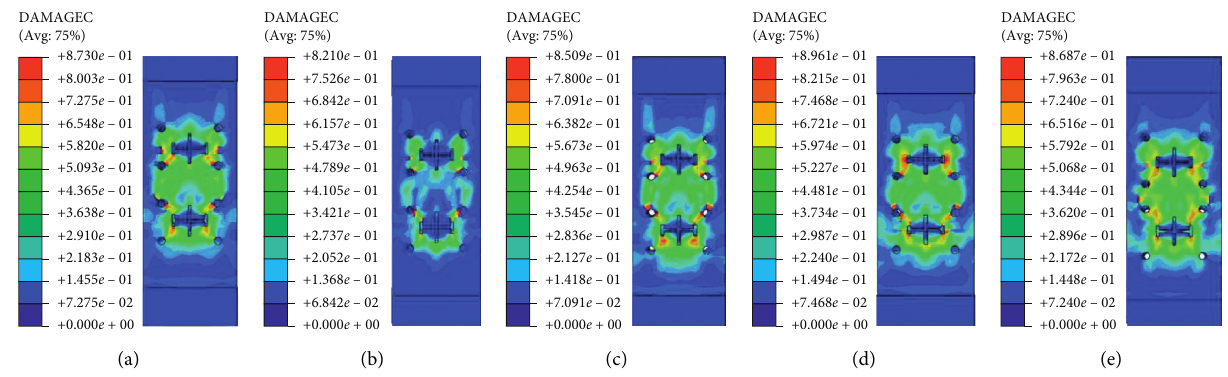
Figure 16: Damage nephogram of concrete: (a) PCB-SLCC-1; (b) PCB-SLCC-2; (c) PCB-SLCC-3; (d) PCB-SLCC-4; (e) PCB-SLCC-5.